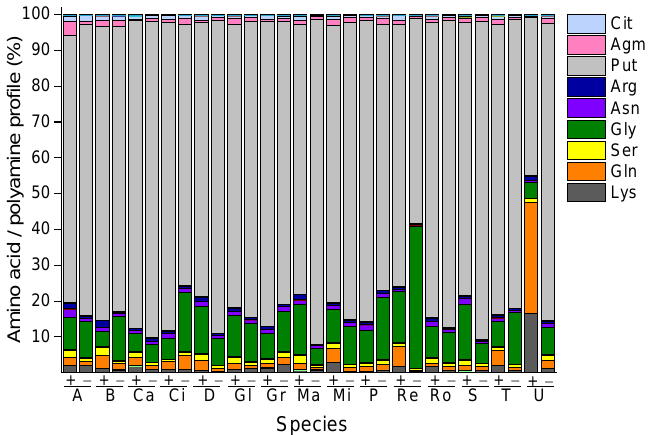
Figure 6. Total amino acid and polyamines (Aa/PolyA) exuded by the roots of fifteen eucalypt spe- cies grown under low (Low P, clear color) and sufficient (Suff P, dark color) phosphorus concentra- tions. Different letters indicate significant differences between low and sufficient P concentrations within each species by the Tukey test ( p < 0.05). Species abbreviations: A— E. acmenoides , B— E. brassiana, Ca— E. camaldulensis , Ci— C. citriodora , D— E. deanei , Gl— E. globulus , Gr— E. grandis , Ma— C. maculata , Mi— E. microcorys , P— E. pellita , Re— E. resinifera , Ro— E. robusta , T— E. tereticornis , S— E. saligna , U— E. urophylla.